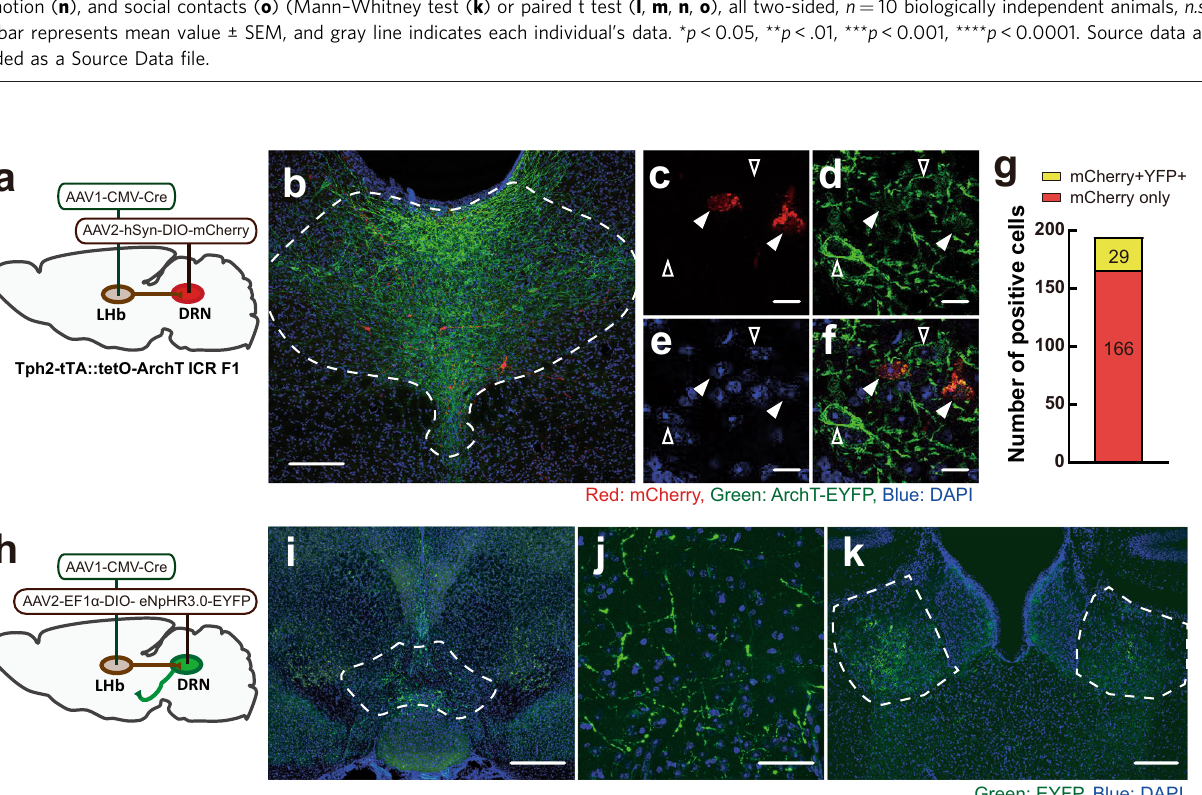
Fig. 7 LHb-DRN projection mainly targets non-5-HT neurons in the DRN. a Schematics of AAV1-CMV-Cre injection into unilateral LHb and Cre- dependent AAV2-hSyn-DIO-mCherry injection into the DRN of Tph2-tTA::TetO-eArchT-EYFP transgenic mice. b mCherry-expressing cells (red) were observed in the DRN. 5-HT neurons were labeled by eArchT-EYFP (green) (scale bar 200 μ m). Enlarged pictures of mCherry ( c ), ArchT-EYFP ( d ), DAPI ( e ), and their merge ( f ) (scale bar 50 μ m). Arrowheads indicate ArchT-EYFP-expressing cells (without fi ll) and ArchT-EYFP- mCherry + cells ( fi lled). g Ratio of mCherry + cells that colocalized with ArchT-EYFP (yellow, 29 cells (14.9%)) and without ArchT-EYFP (red, 166 cells (85.1%)) in the DRN ( n = 3 biologically independent animals). h Schematics of AAV1-Cre injection into unilateral LHb and Cre-dependent AAV2-EF1 α -DIO-eNpHR3.0-EYFP into the DRN to observe projections to forebrain areas. i – k EYFP-expressing fi bers (green) were observed in the medial part of the VTA ( i scale bar 500 μ m, j